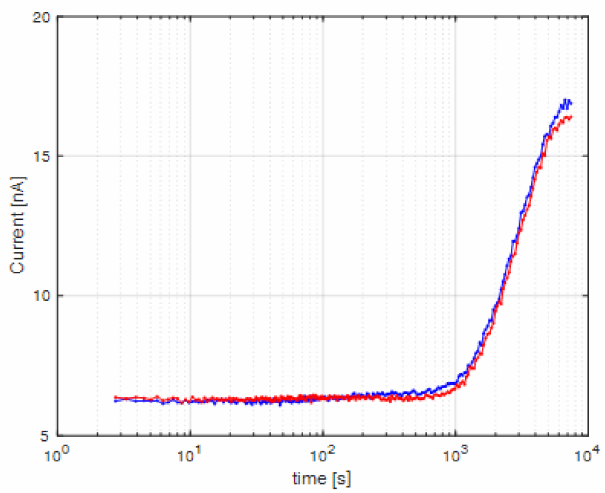
Figure 5. Simultaneous bioluminescence signal measurement from two replicate samples as a function of incubation time on SiPM chip. Solutions contained E. coli with OD 600 of 0.1 mixed with 25 µ g L − 1 of Hg 2+ , incubated at room temperature. Inset: re-designed optical set-up containing two detection